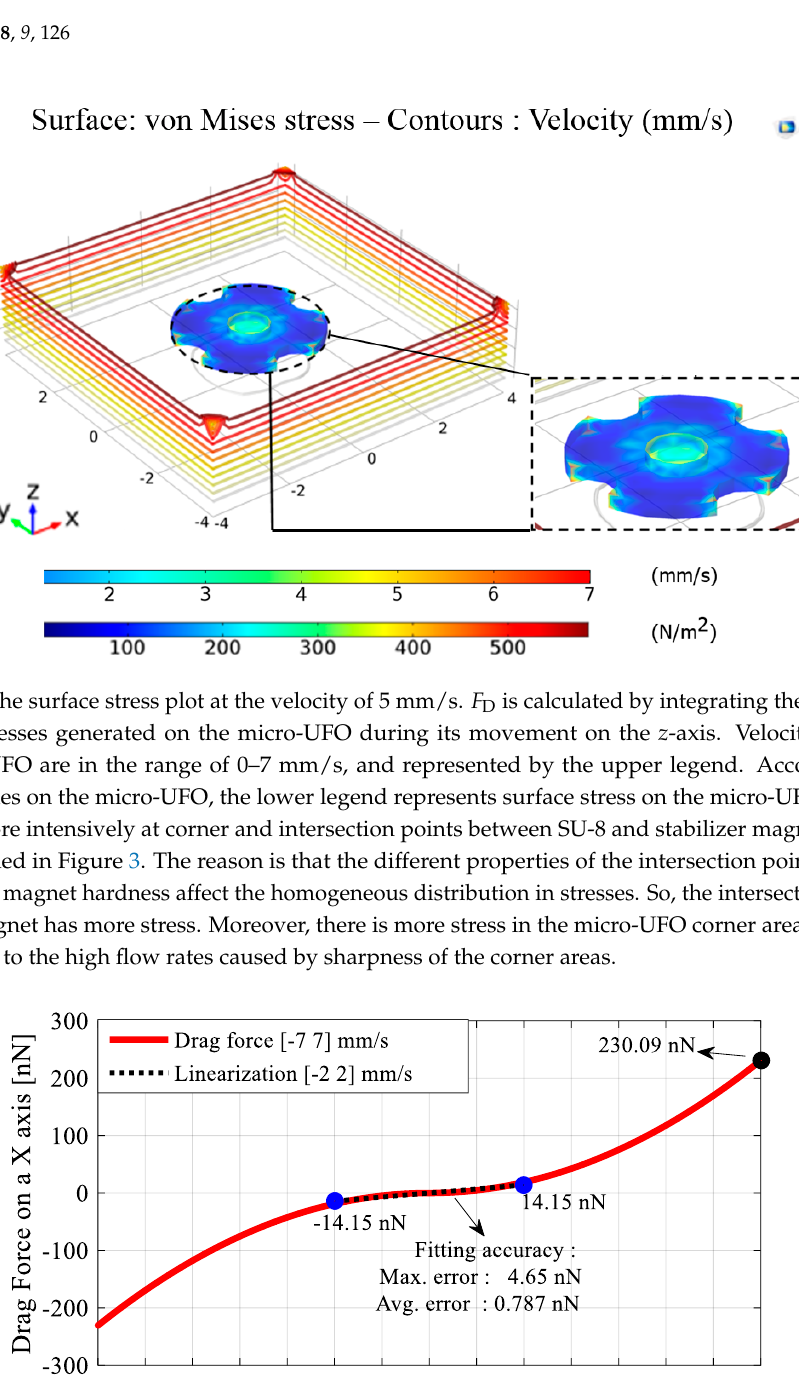
Figure 8. Fourier transform infrared (FTIR) spectrum of magnet coated with polydopamine (PDA). The peak between wavelength of 1500 – 1650 cm −1 indicates N – H vibrations, and peak between wavelength of 3200 – 3600 cm −1 indicates hydroxyl groups in the structure. This proves successful coating of magnet surface. 3.2. Micro-UFO Fabrication